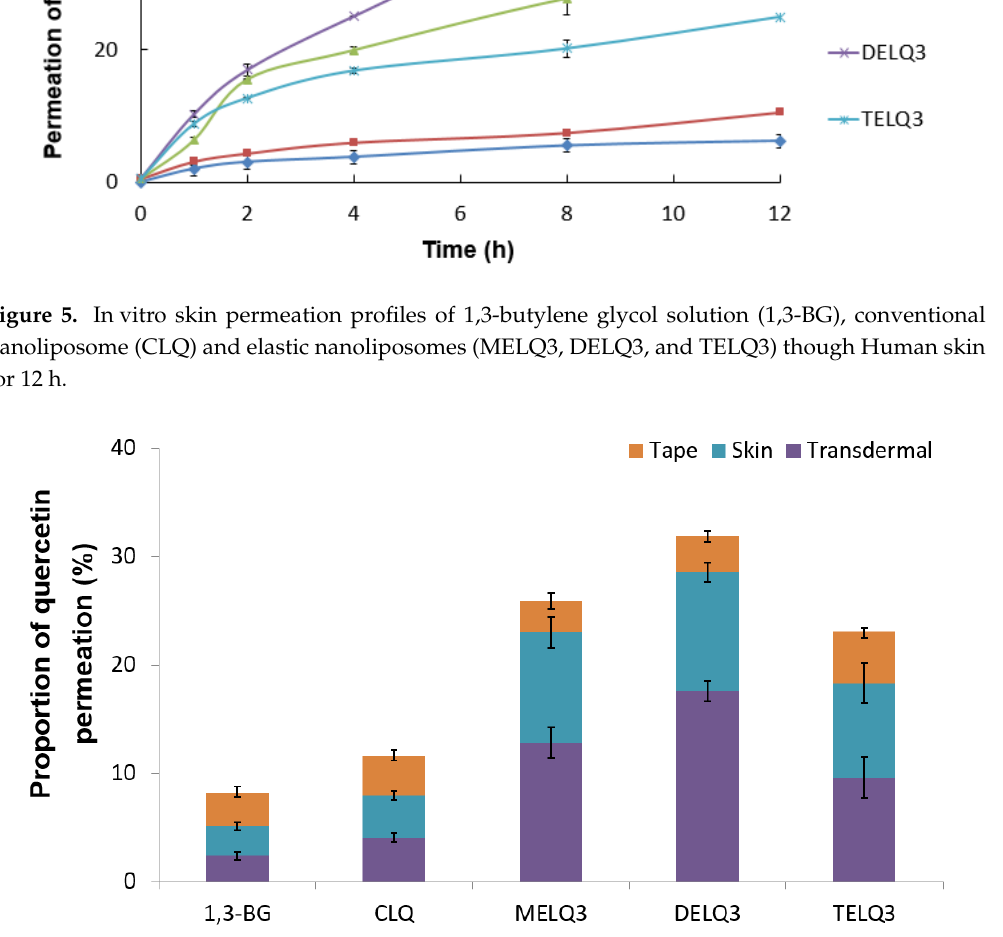
Figure 5. In vitro skin permeation profiles of 1,3-butylene glycol solution (1,3-BG), conventional nanoliposome (CLQ) and elastic nanoliposomes (MELQ3, DELQ3, and TELQ3) though Human skin for 12 h.